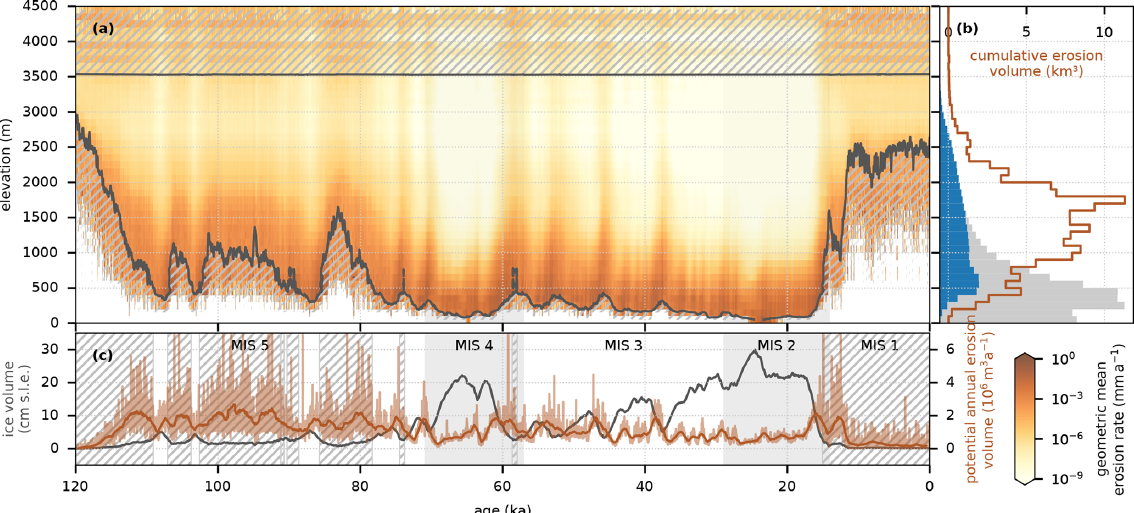
Figure 4. (a) Potential erosion rate “hypsogram”, showing the geometric mean of modelled rates in 100m elevation bands across the entire model domain and its time evolution. Hatching indicates elevation bands with fewer than a hundred grid cells (100km 2 ). (b) Distribution of model domain bedrock topography (grey bars) and glaciated topography (blue bars) in 100m elevation bands and the corresponding cumulative potential erosion volume (brown line). (c) Same as Fig.